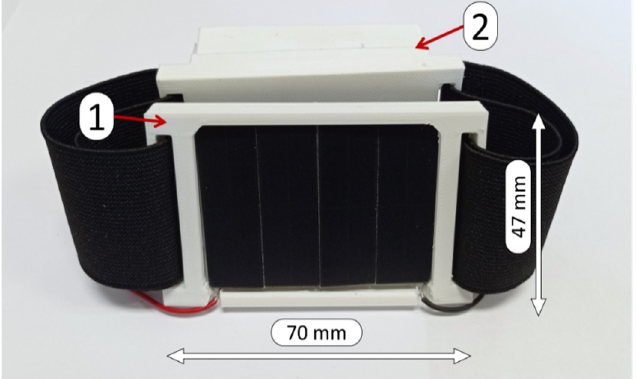
Figure 8. Wearable device prototype. 1: solar cells module housing. 2: PCB and flexible battery hous ‐ ing.